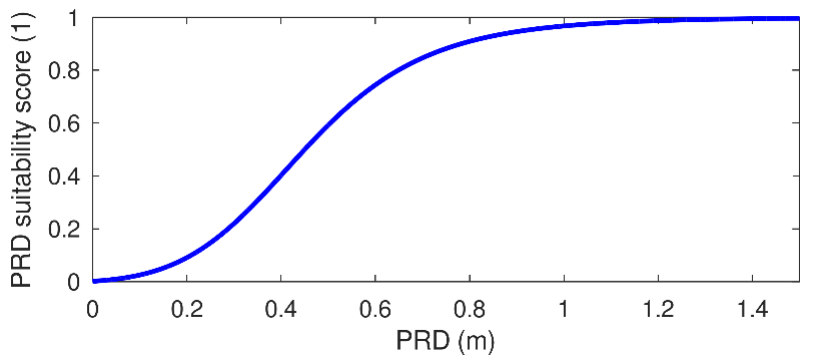
Figure 7 . Rooting depth score vs. potential rooting depth (PRD) for both apple and kiwifruit. A higher score indicates a more suitable PRD.